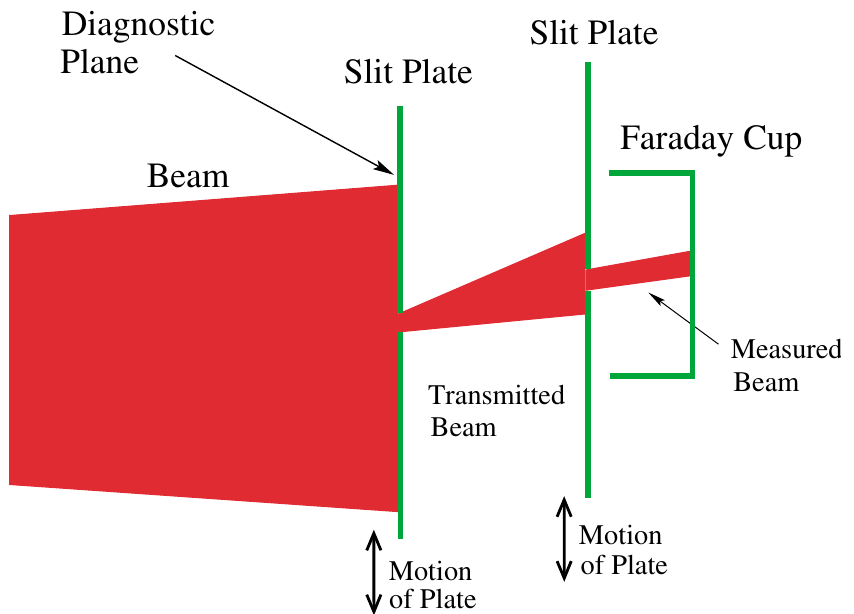
FIG. 1. (Color) Cross section of slit-plate diagnostics for measurement of beam phase